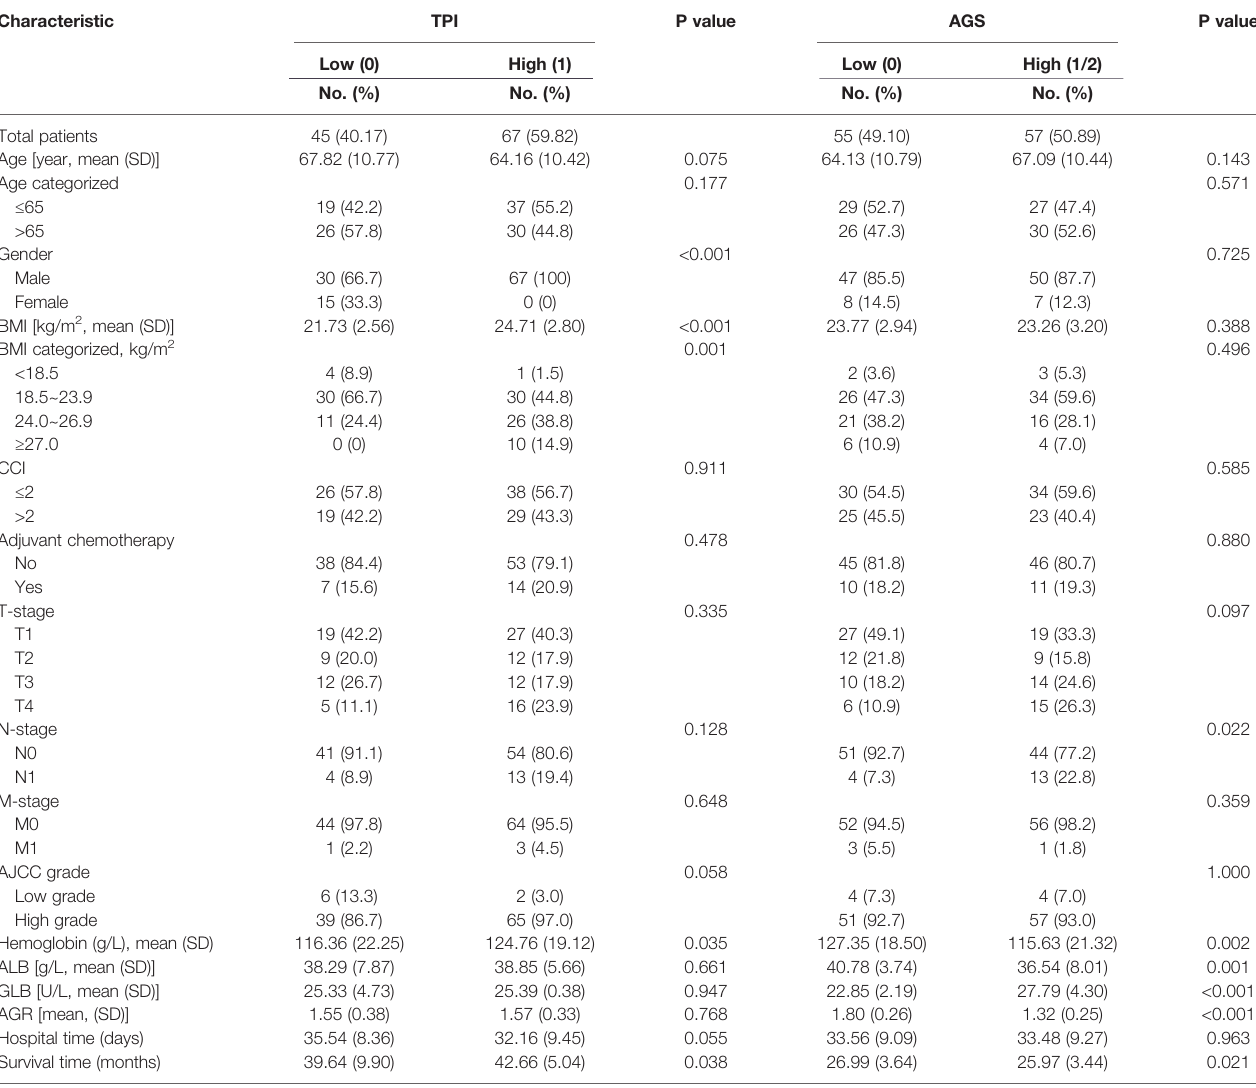
TABLE 2 | Baseline characteristics according to the subgroups classi fi ed by TPI and AGS.